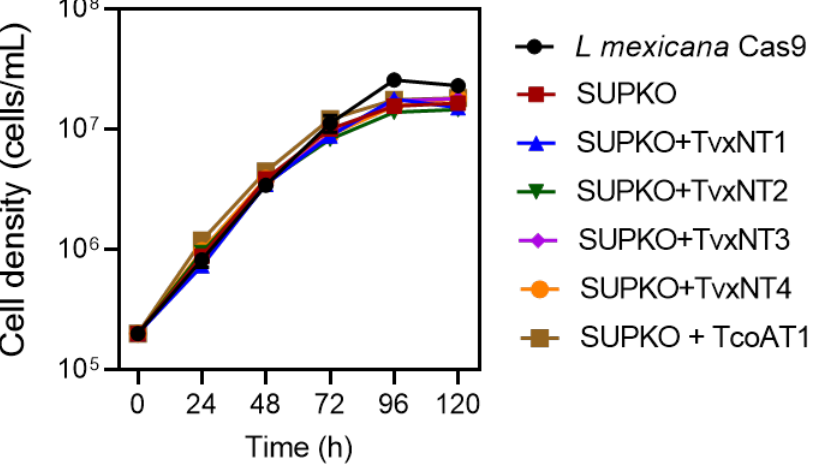
Figure 2. Growth curve of L. mexicana Cas9, SUPKO, and SUPKO clones expressing T. congolense and T. vivax nucleoside transporters. Cells were seeded at density of 2 × 10 5 cells/mL in HOMEM medium and counted manually in a Neubauer chamber viewed under microscope every 24 h. Graph was plotted using the average count of three independent determinations (Mean ± SEM; n = 3). When error bars are not shown they fall within the symbol.